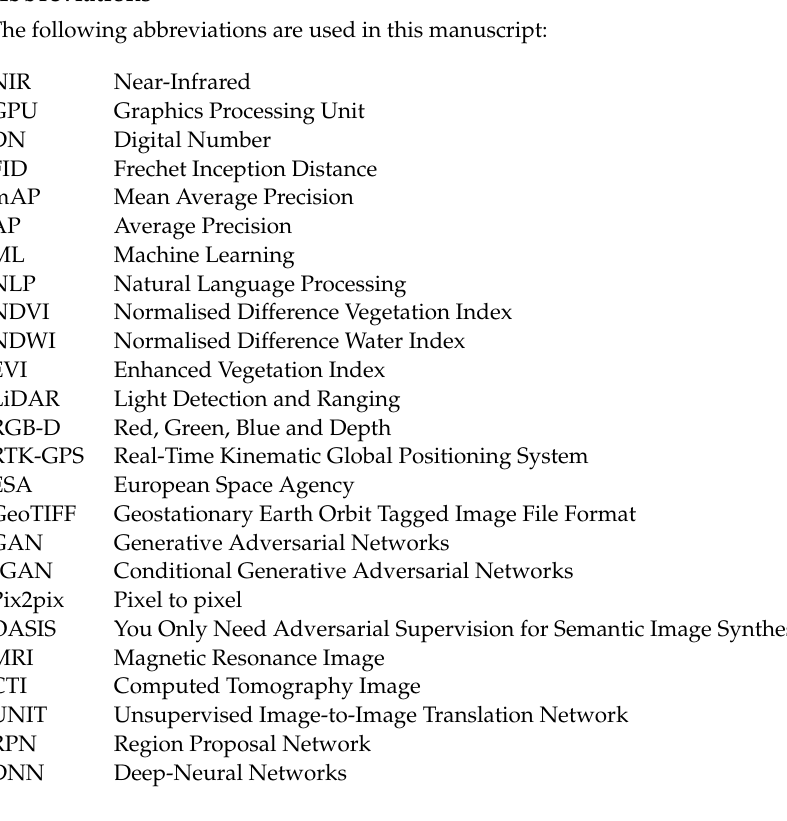
obtained from Google Images; Figure S4: Capsicum prediction results using Yolov5x and RGB test images that achieved 0.49 mAP . This is one of the most challenging dataset that collected [0.5:0.95] complex and cluttered real farm environments. Lighting condition is severe, level of occlusion is high, and distance to objects is far. Images are obtained from [15]; Figure S5: Cherry prediction results using Yolov5x and RGB test images that achieved 0.66 mAP . Images are obtained from Google [0.5:0.95] Images; Figure S6: Kiwi prediction results using Yolov5x and RGB test images that achieved 0.60 mAP . Images are obtained from Google Images; Figure S7: Mango prediction results using [0.5:0.95] Yolov5x and RGB test images that achieved 0.69 mAP . Images are obtained from [15]; Figure S8: [0.5:0.95] Orange prediction results using Yolov5x and RGB test images that achieved 0.73 mAP . Images [0.5:0.95] are obtained from [15]; Figure S9: Mango prediction results using Yolov5x and RGB test images that achieved 0.69 mAP . Top row images are obtained from [15] and bottom are from Google [0.5:0.95] Images; Figure S10: Strawberry prediction results using Yolov5x and RGB test images that achieved 0.67 mAP . Images are obtained from [15]; Figure S11: Wheat prediction results using Yolov5x [0.5:0.95] and RGB test images that achieved 0.56 mAP Images are obtained from Kaggle wheat detection [0.5:0.95]